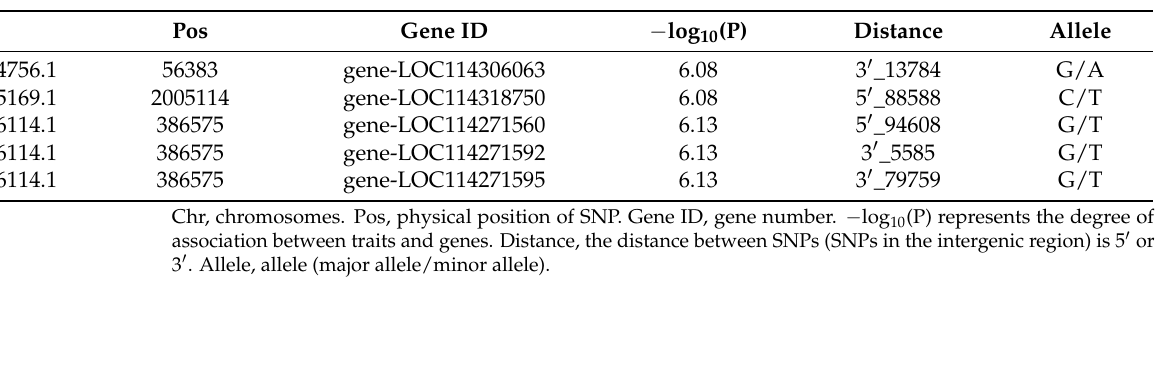
Table 7. Candidate genes related to the development of leaf color.